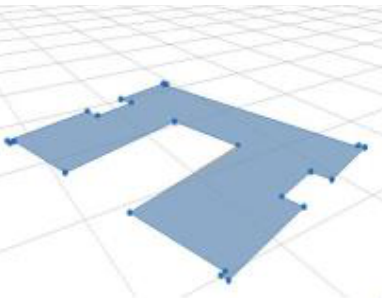
Figure 9: The 2D building